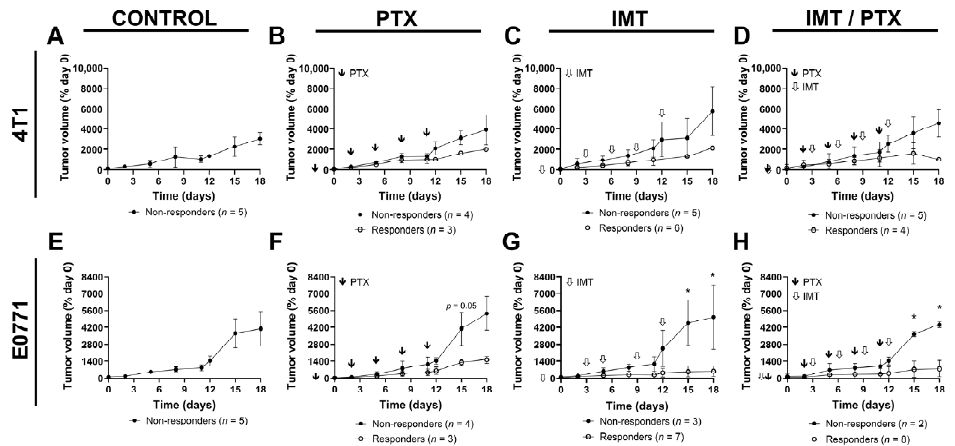
Figure 5. Mice were sorted into non-responder and responder groups based on tumor volume. Mice bearing ( A – D ) 4T1 and ( E – H ) E0771 tumors were separated into non-responder and responder groups for the purpose of analyzing FMISO-PET predictive value. Mean ± SD (* indicates p < 0.05; multiple t -tests).